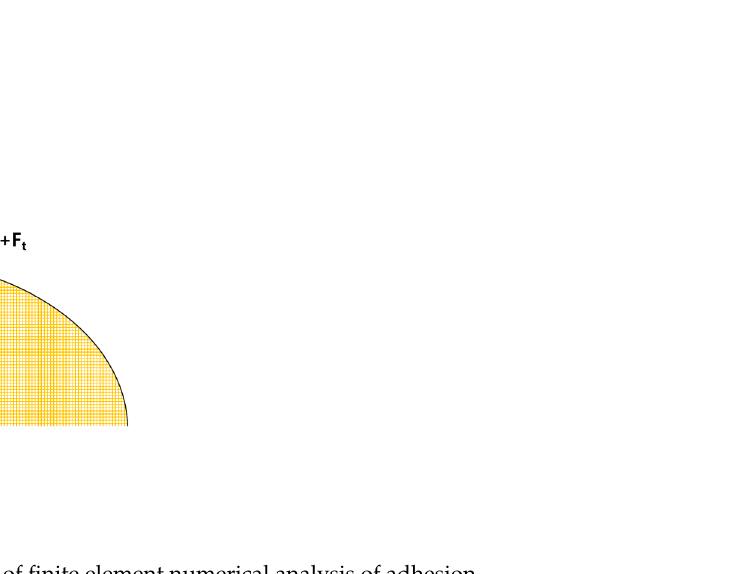
Figure 3. Modelling of finite element numerical analysis of adhesion.